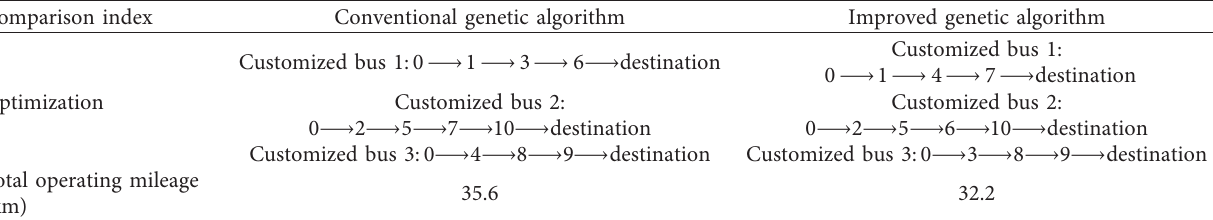
Table 4: Comparison of optimization schemes obtained by different